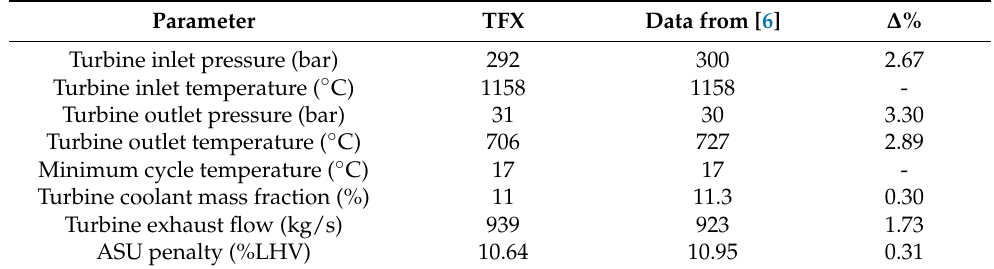
Table 2. Validation of the base-case model.